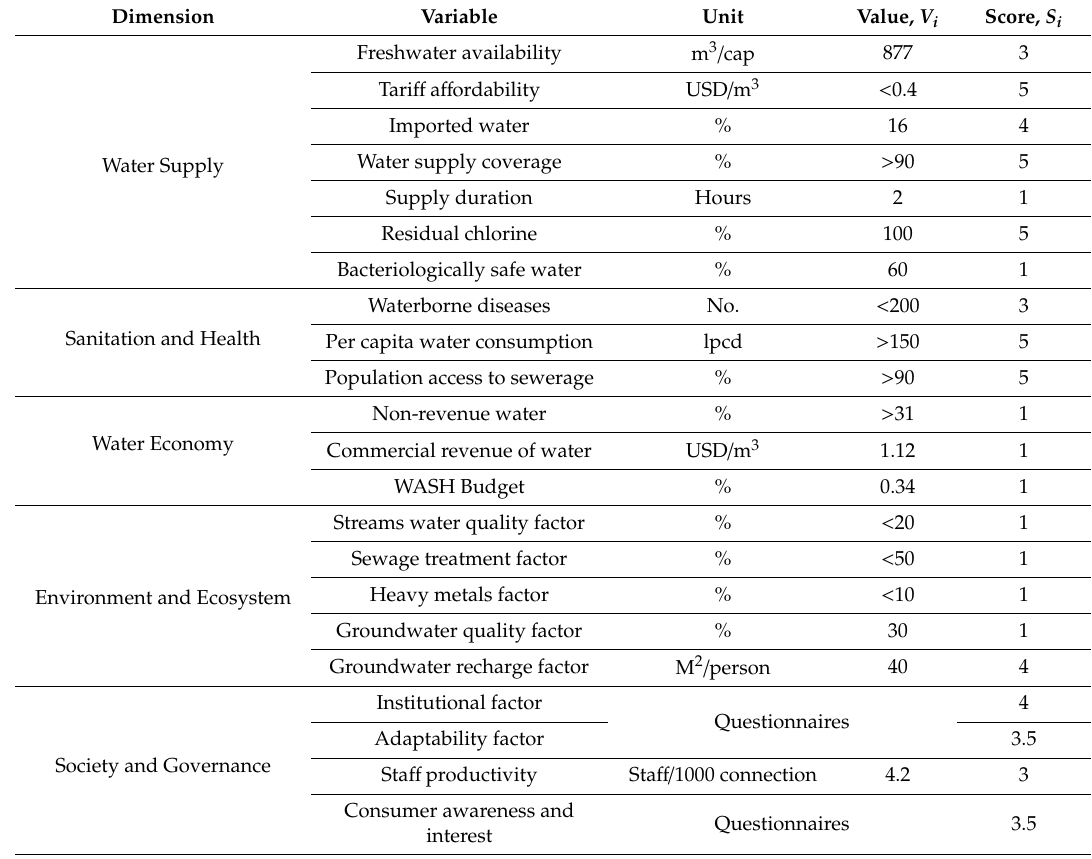
Figure 4. Islamabad’s UWSI dimensions. Table 8. Islamabad’s UWSI variables and their scores.